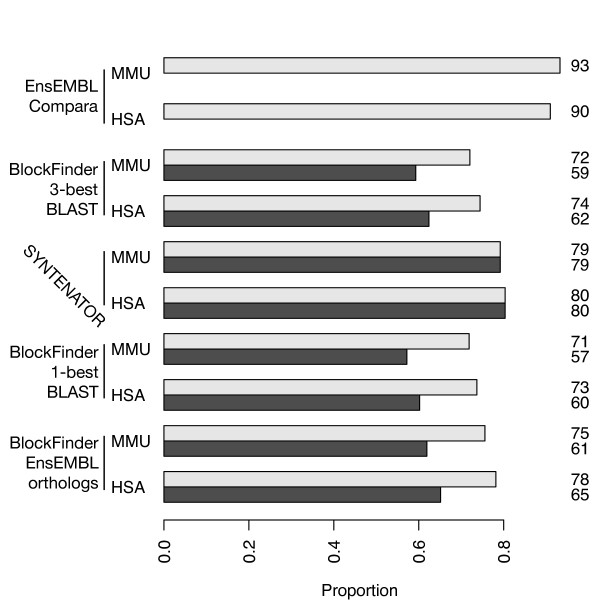
Pairwise comparison of the human and mouse genome with Blockfinder and Syntenator. Dark gray bars represent the proportion of man (HSA) and mouse (MMU) genes, which could be aligned. Light gray bars represent the proportion of human and mouse genes, which fall into regions that are covered by alignments. Both number are the same for Syntenator as it considers all genes of a genome simultaneously. The "EnsEMBL Compara" bars are taken from the EnsEMBL synteny blocks. The three other runs were conducted with BlockFinder and differing sets of homology relations (see text). The number to the right of each bar is the proportion relative to the total gene set in percentage.